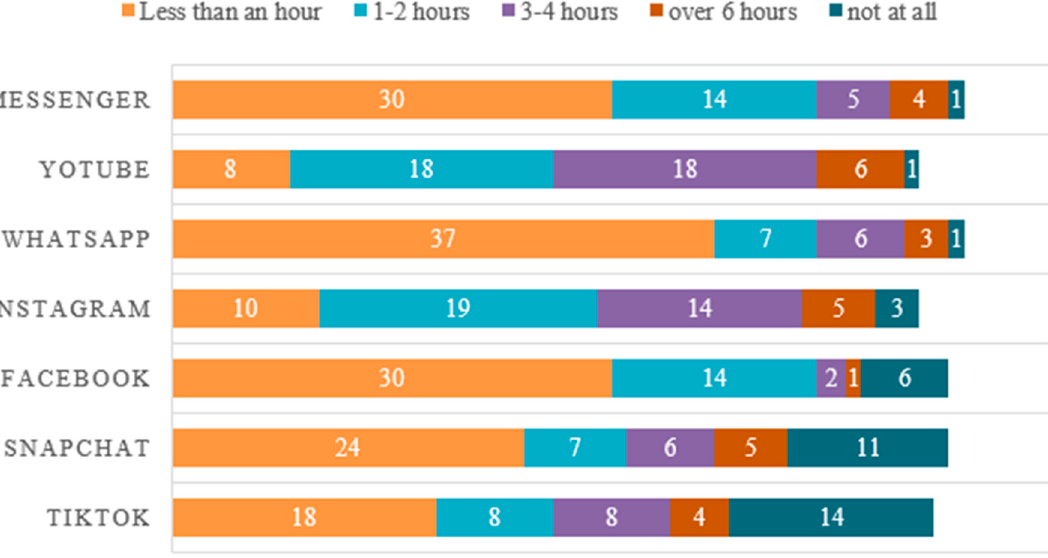
Figure 2. Favorite apps and social networks.